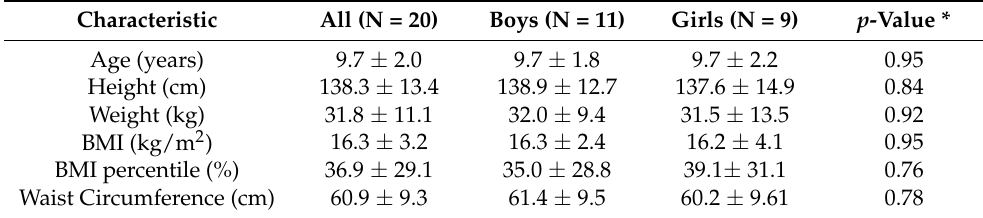
Table 1. Descriptive characteristics of participants, mean ± standard deviation.